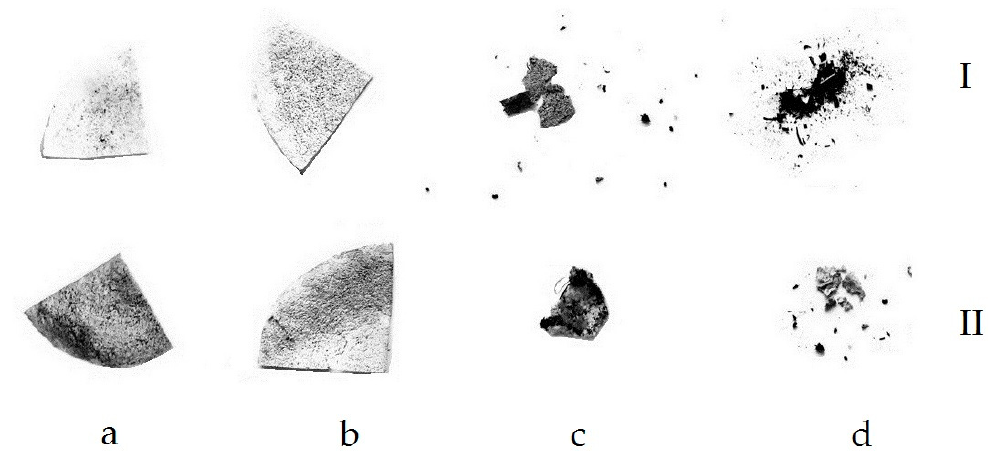
Figure 8. Photographs of PHB-chitosan films (I) and films containing sorbed iron ions (II), after ex- position in soil during 2 ( a ), 4 ( b ), 7 ( c ) and 12 ( d ) weeks.